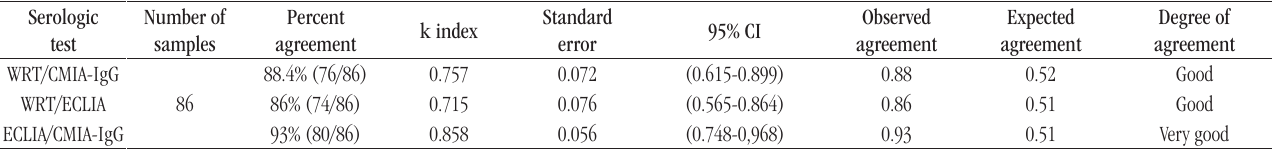
TABLE 4 – The degree of agreement between serological tests in epidemiological survey samples Serologic